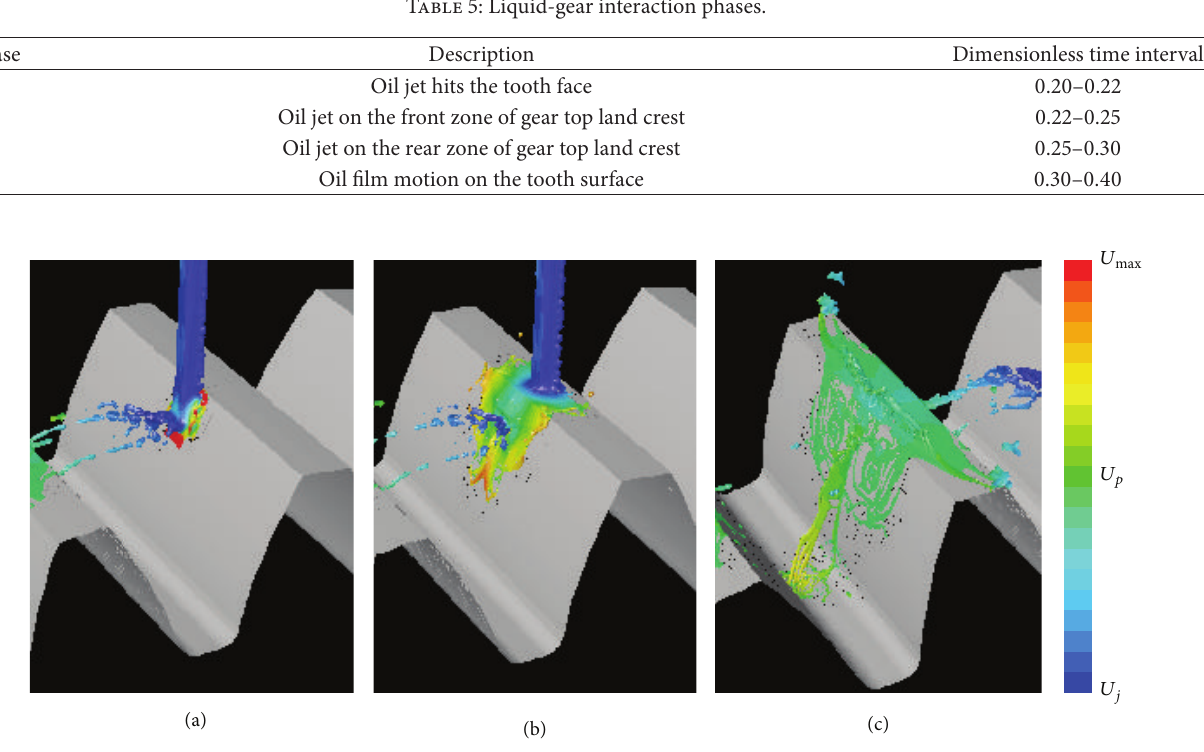
Figure 13: Run 1: contour plot of velocity on the liquid surface.